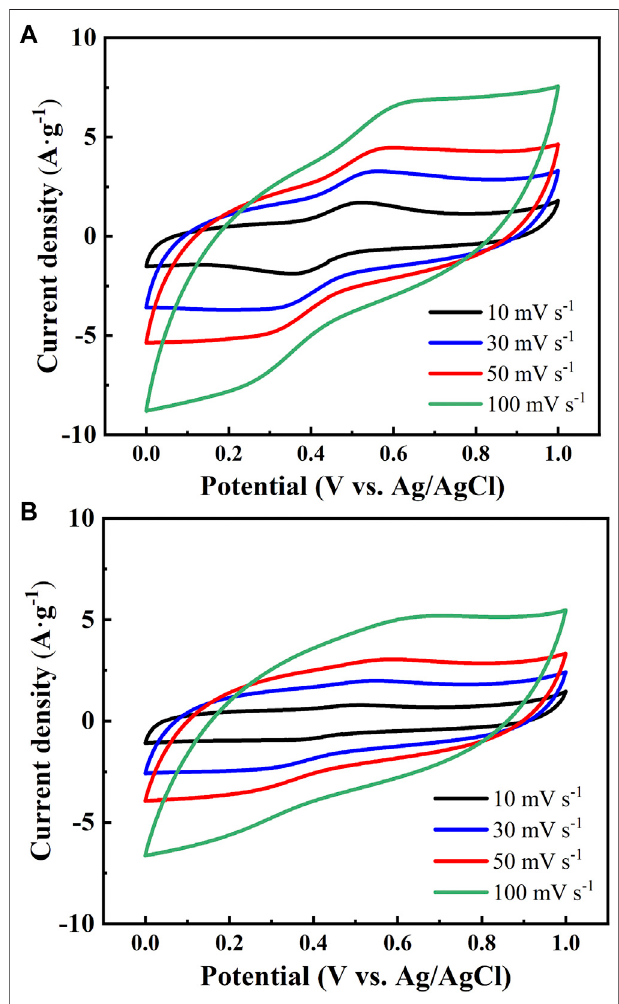
FIGURE 7 | Cyclic voltammetry pro fi les of (A) YP-AC and (B) SG-AC electrodes in 1 M H 2 SO 4 at different scan rates.